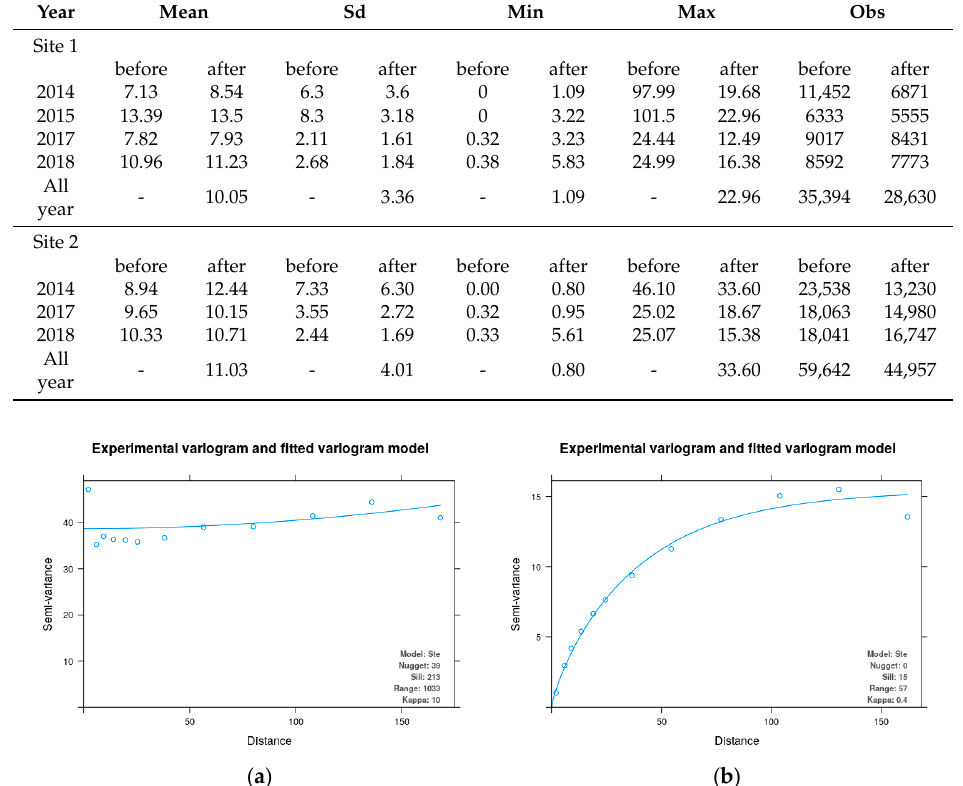
Table 4. Statistics of yield monitor data values before and after-spatial filtering.